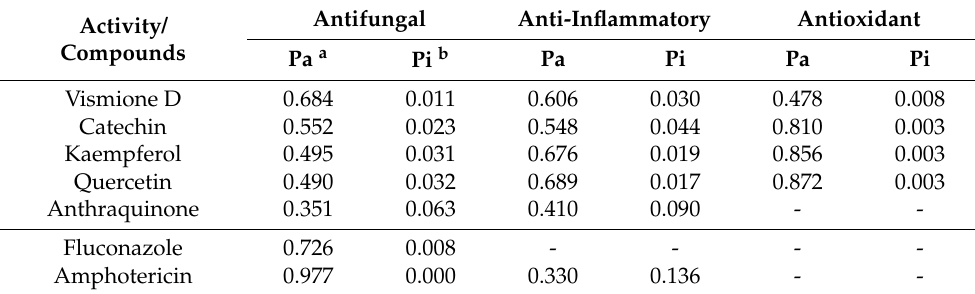
Table 4. PASS prediction of commercial drugs and three selected compounds detected in the Vismia guianensis extract, considering the Potential activity (Pa) higher than potential inactivity (Pi), as well as the antifungal, antioxidant, and anti-inflammatory activities.